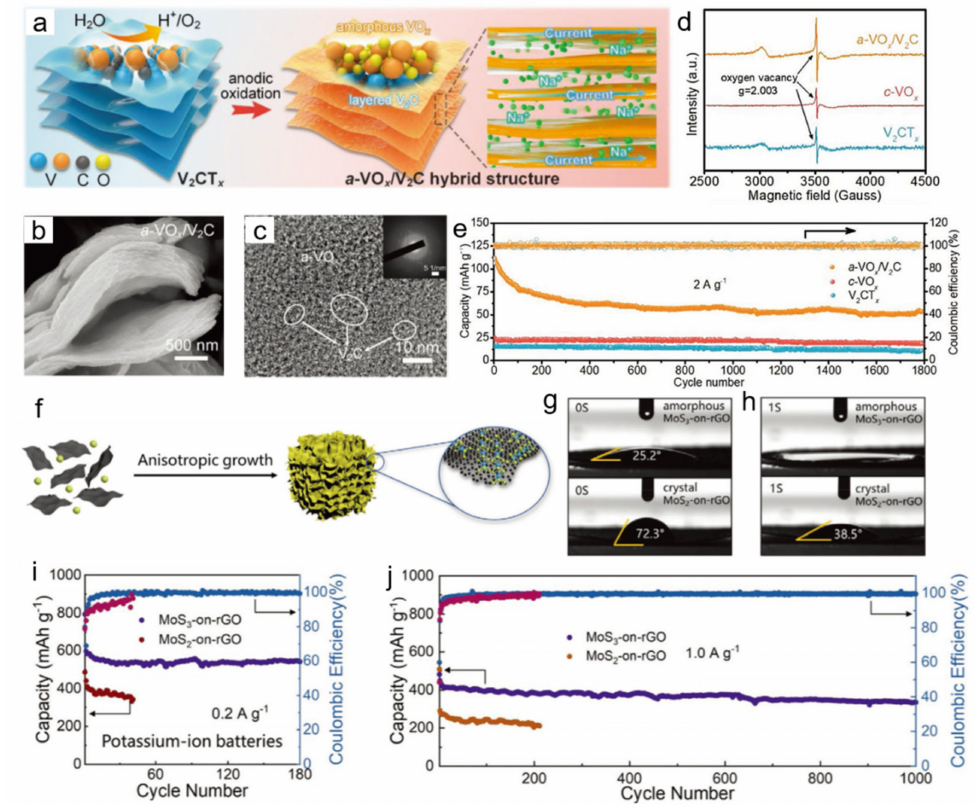
Figure 4. ( a ) Schematic illustration showing the synthesis and structure; ( b ) SEM image; ( c ) HRTEM image, the inset is the SAED pattern; ( d ) EPR spectra; ( e ) Cycling performances of a-VO x /V 2 C. Reprinted with permission from Ref. [52]. Copyright Wiley-VCH, 2021. ( f ) Schematic illustration of growth behaviors of amorphous MoS 3 -on-rGO; ( g , h ) Contact angle images of electrolyte on the electrode surface of amorphous MoS 3 -on-rGO and crystal MoS 2 -on-rGO. ( i ) Cyclic performance of KIB at 0.2 A g − 1 . ( j ) Long cycle performance of KIB at 1.0 A g − 1 . Reprinted with permission from Ref. [53]. Copyright Wiley-VCH,